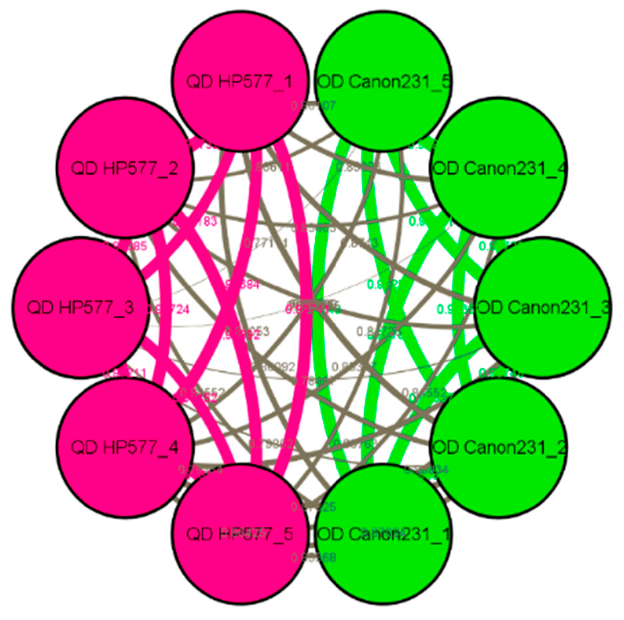
Figure 1. Test 1 visualization.